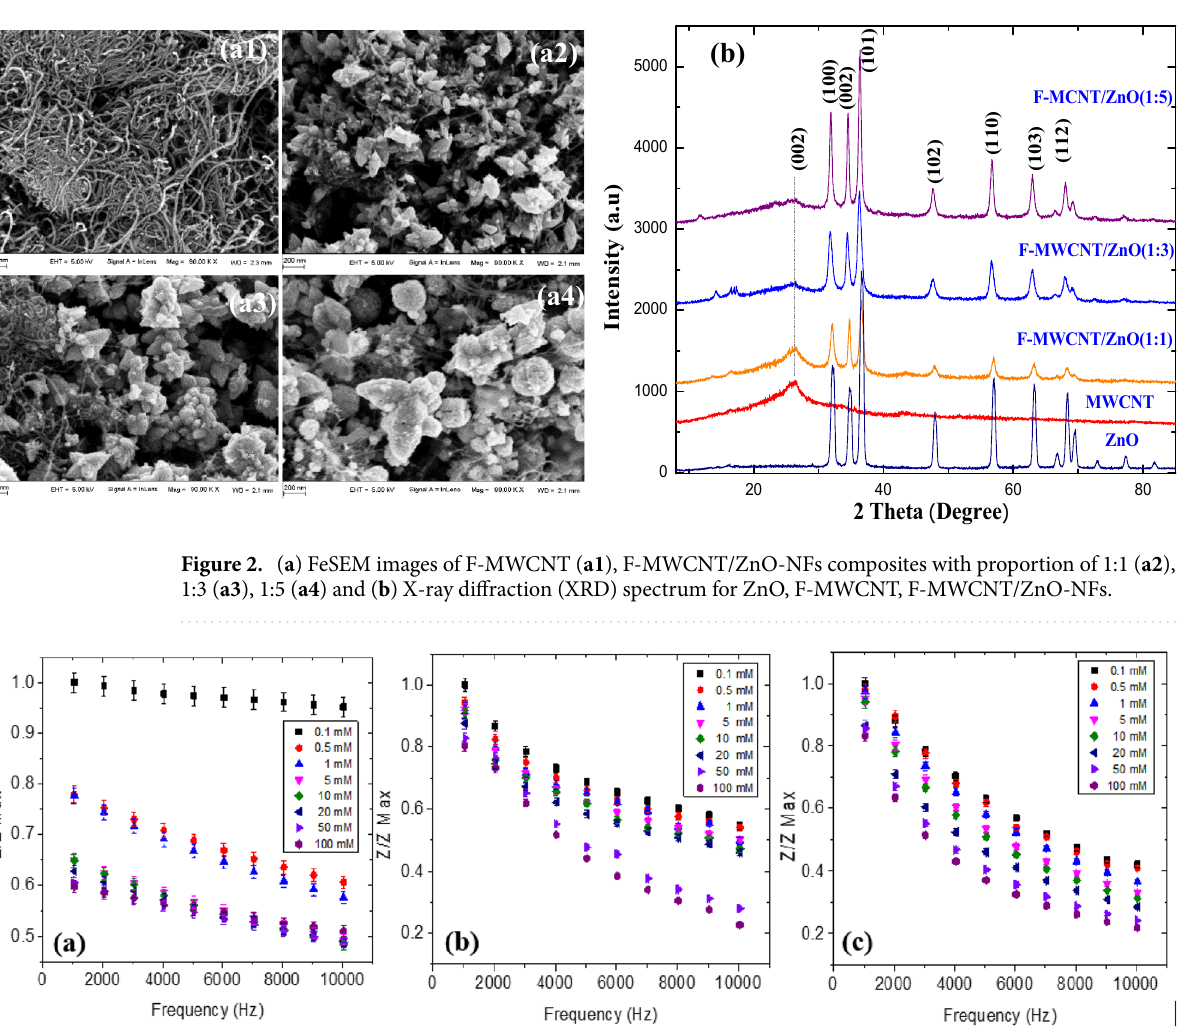
Figure 3. Impedance (Z/Z max ) versus frequency response of the sensors ( a ) S1, ( b ) S2 and ( c ) S3 at 0.1–100 mM